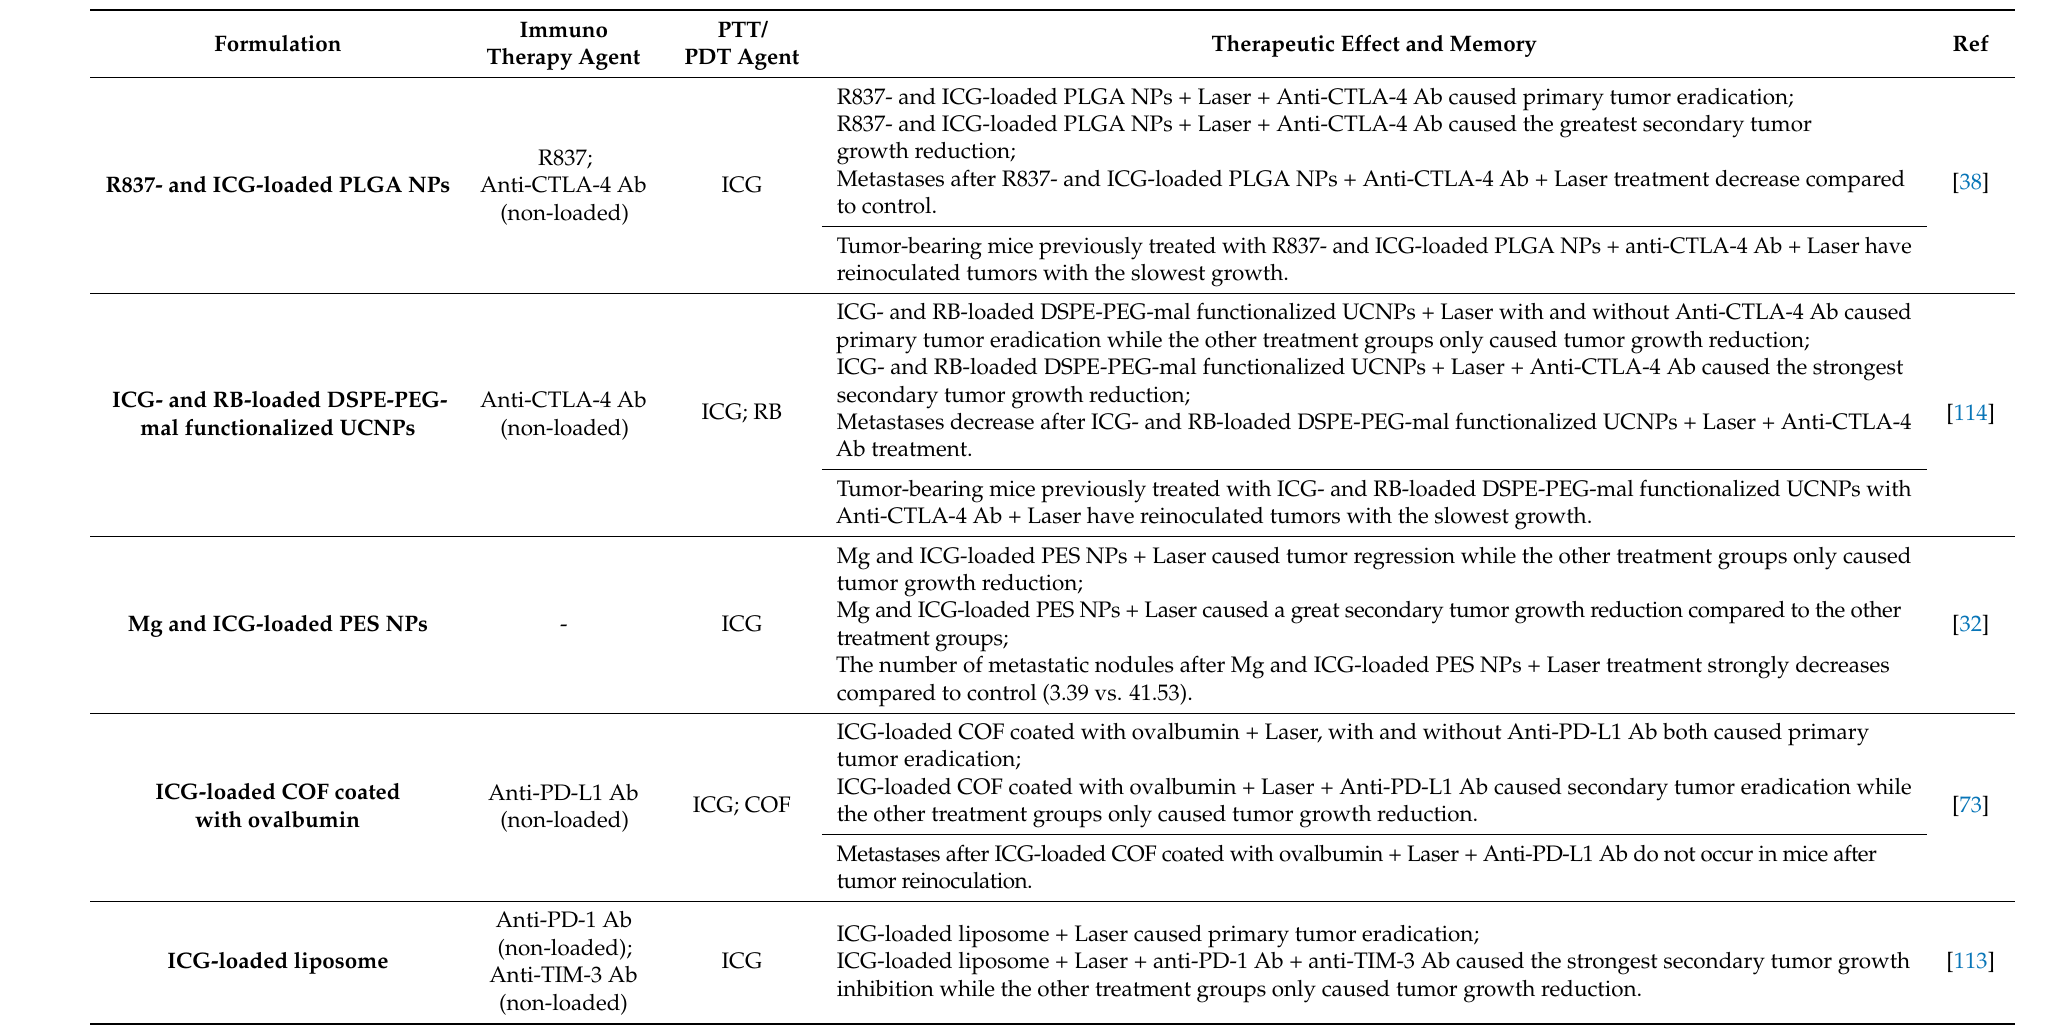
Table 2. Outcome generated by the immuno-PTT/PDT mediated by ICG-based nanomaterials in the primary/secondary tumors and tumor